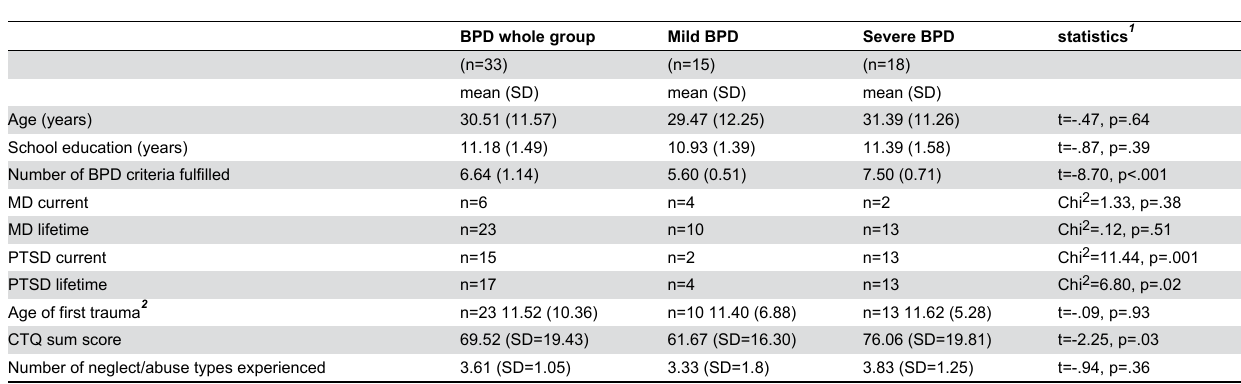
Table 1. Characteristics of psychopathology in the BPD total group and of both patient